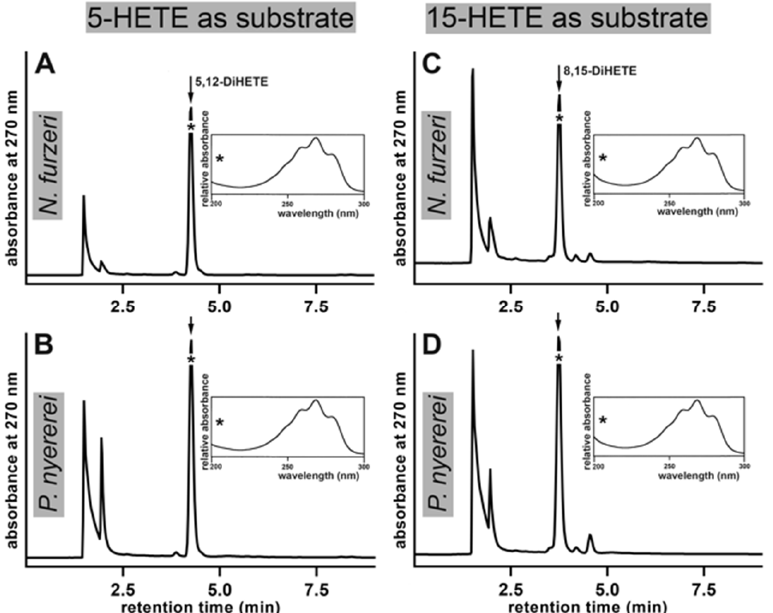
Figure 8. Oxygenation of 5 R/S -HETE, 15 R/S -HETE by bony fish ALOX-isoforms. ALOX activity assays (substrate concentration 30 µ M) were carried out using the cellular lysate supernatants as enzyme source. After 10 min of incubation the reaction products were reduced and analyzed by RP-HPLC recording the absorbance at 270 nm. The uv-spectra of the major oxygenation products were taken during the chromatographic run at the time points indicated (*). The chemical structures of the major oxygenation products were confirmed by LC-MS analysis. ( A ) N. furzeri ALOX, 5-HETE as substrate, ( B ) P. nyererei ALOX, 5-HETE as substrate, ( C ) N. furzeri ALOX, 15-HETE, as substrate ( D ) P. nyererei ALOX, 15-HETE as substrate. For better comparison of the product profiles each chromatogram was scaled to the highest conjugated triene peak. Thus, the amounts of products formed by the two enzymes cannot directly be compared. Table 1. Substrate specificity of bony fish ALOX-isoforms with oxygenated polyenoic fatty acids. Different oxygenated metabolites of polyenoic fatty acids were used for comparative activity assays. For these assays the different substrates were incubated in PBS (30 µ M substrate concentration) and the rates of substrate conversion during a 10 min incubation period was assayed by RP-HPLC. The rate of AA conversion was set 100% and the relative conversion of the other substrates was calculated. Cellular lysate supernatants were used as enzyme source and identical amounts of enzyme were added to the different substrates. n.i. not